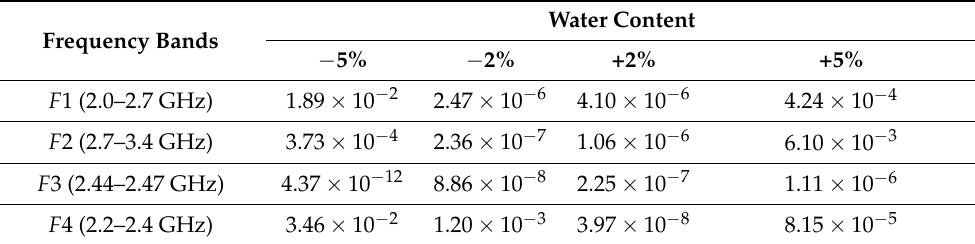
Table 1. p -values of two-sample t -tests for selection of frequency bands having discriminatory power in gel studies. Frequency